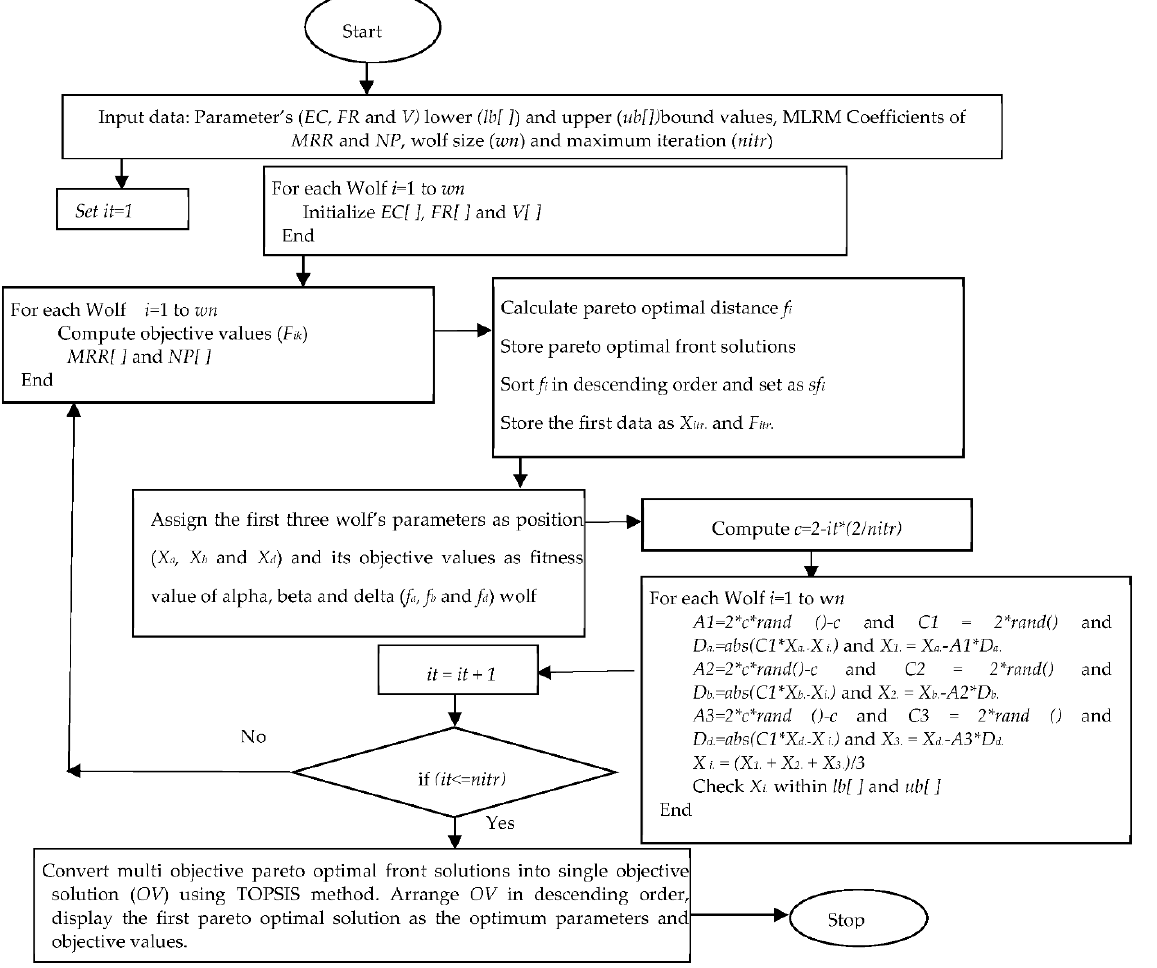
Figure 12. Implementation of GWO algorithm.